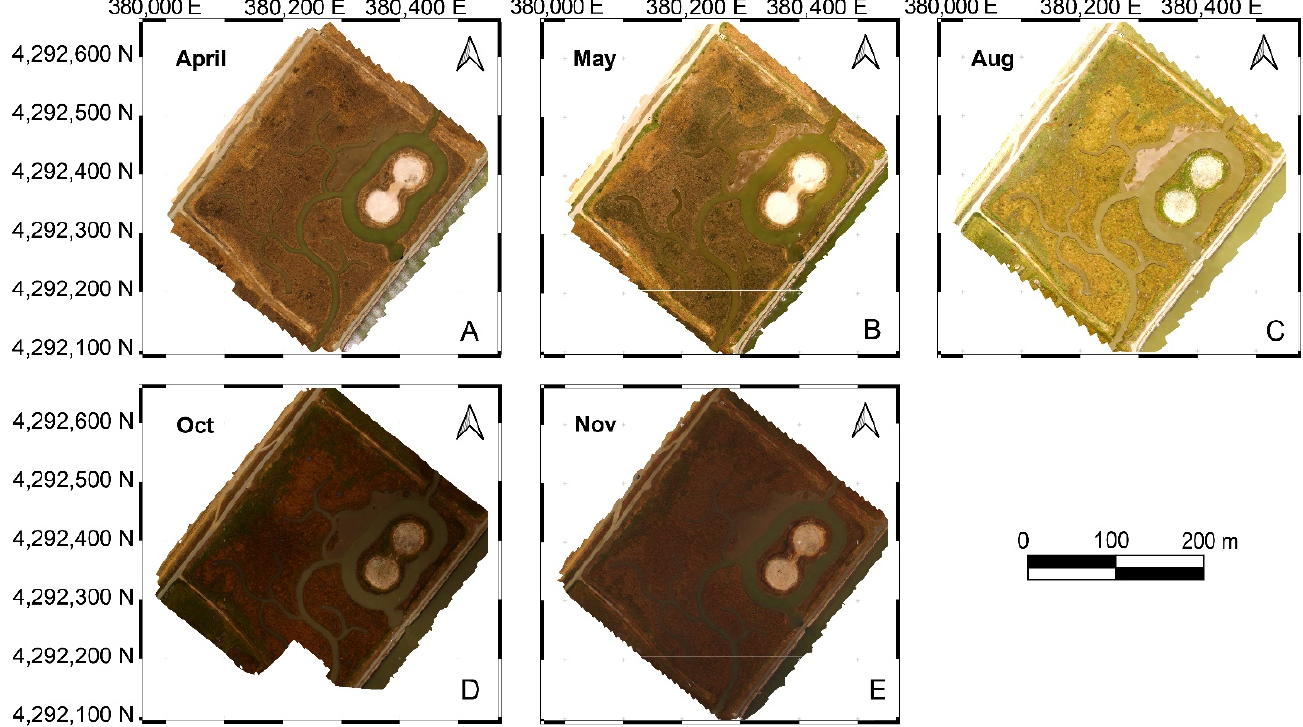
Figure 6. Orthophotos from RGB camera images elaboration for the Cell 1B in the five months surveyed. ( A ) April 2019, ( B ) May 2019, ( C ) August 2019, ( D ) October 2019 and ( E ) November 2019.